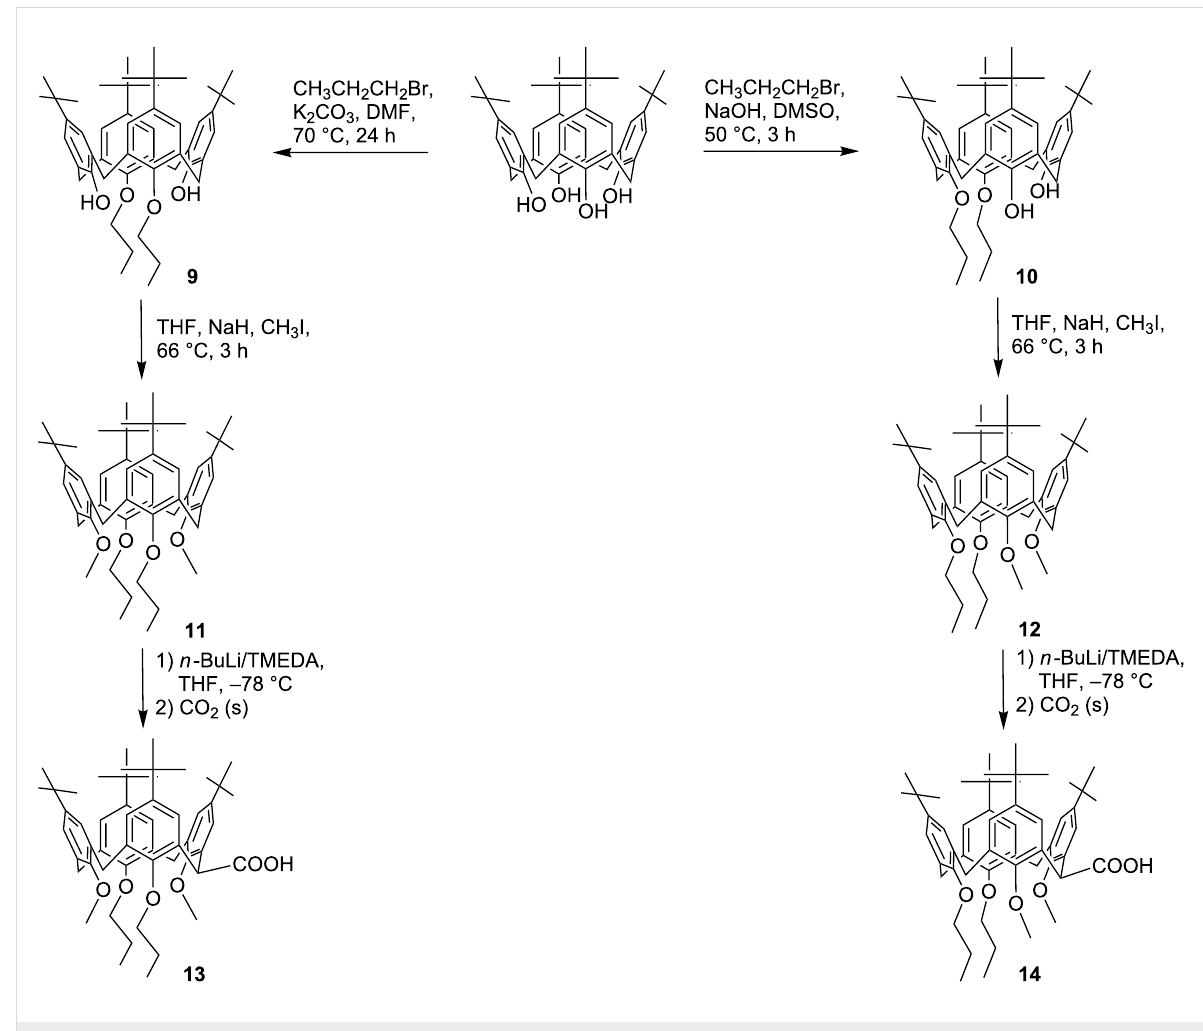
Scheme 2: Pathways to the calixarene acids 13 and 14 bearing mixed ether functions in different